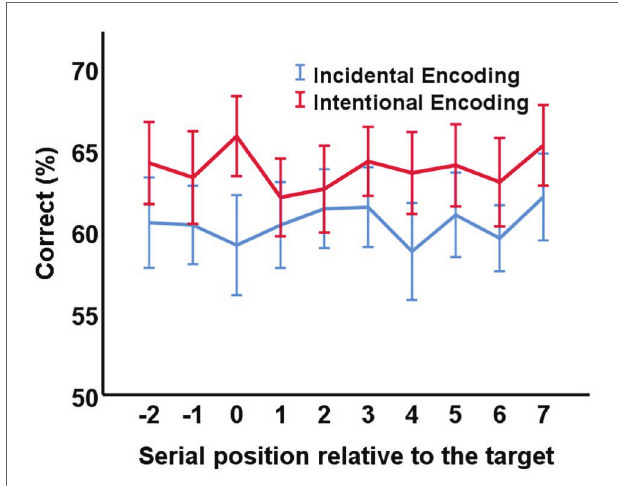
FIGURE 2 | Results. The percentage of correctly remembered pictures is shown as a function of condition ( incidental encoding vs. intentional encoding ) and serial position ( − 2 to +7). Serial position 0 represents the presentation of a target square. Error bars represent 95% confidence intervals.